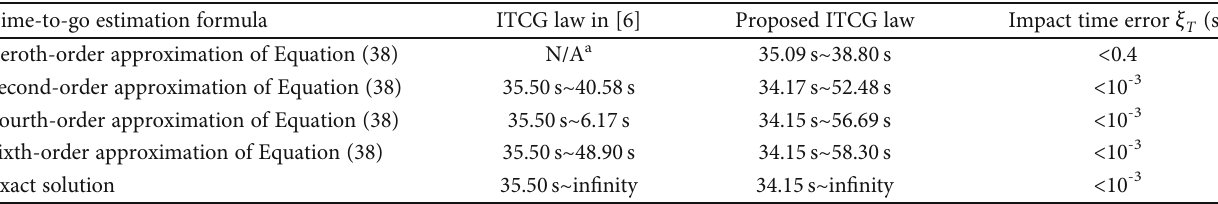
Figure 4: Results of proposed ITCG law using di ff erent time-to-go estimation formulas. Table 1: Comparison of controllable ranges of the desired impact